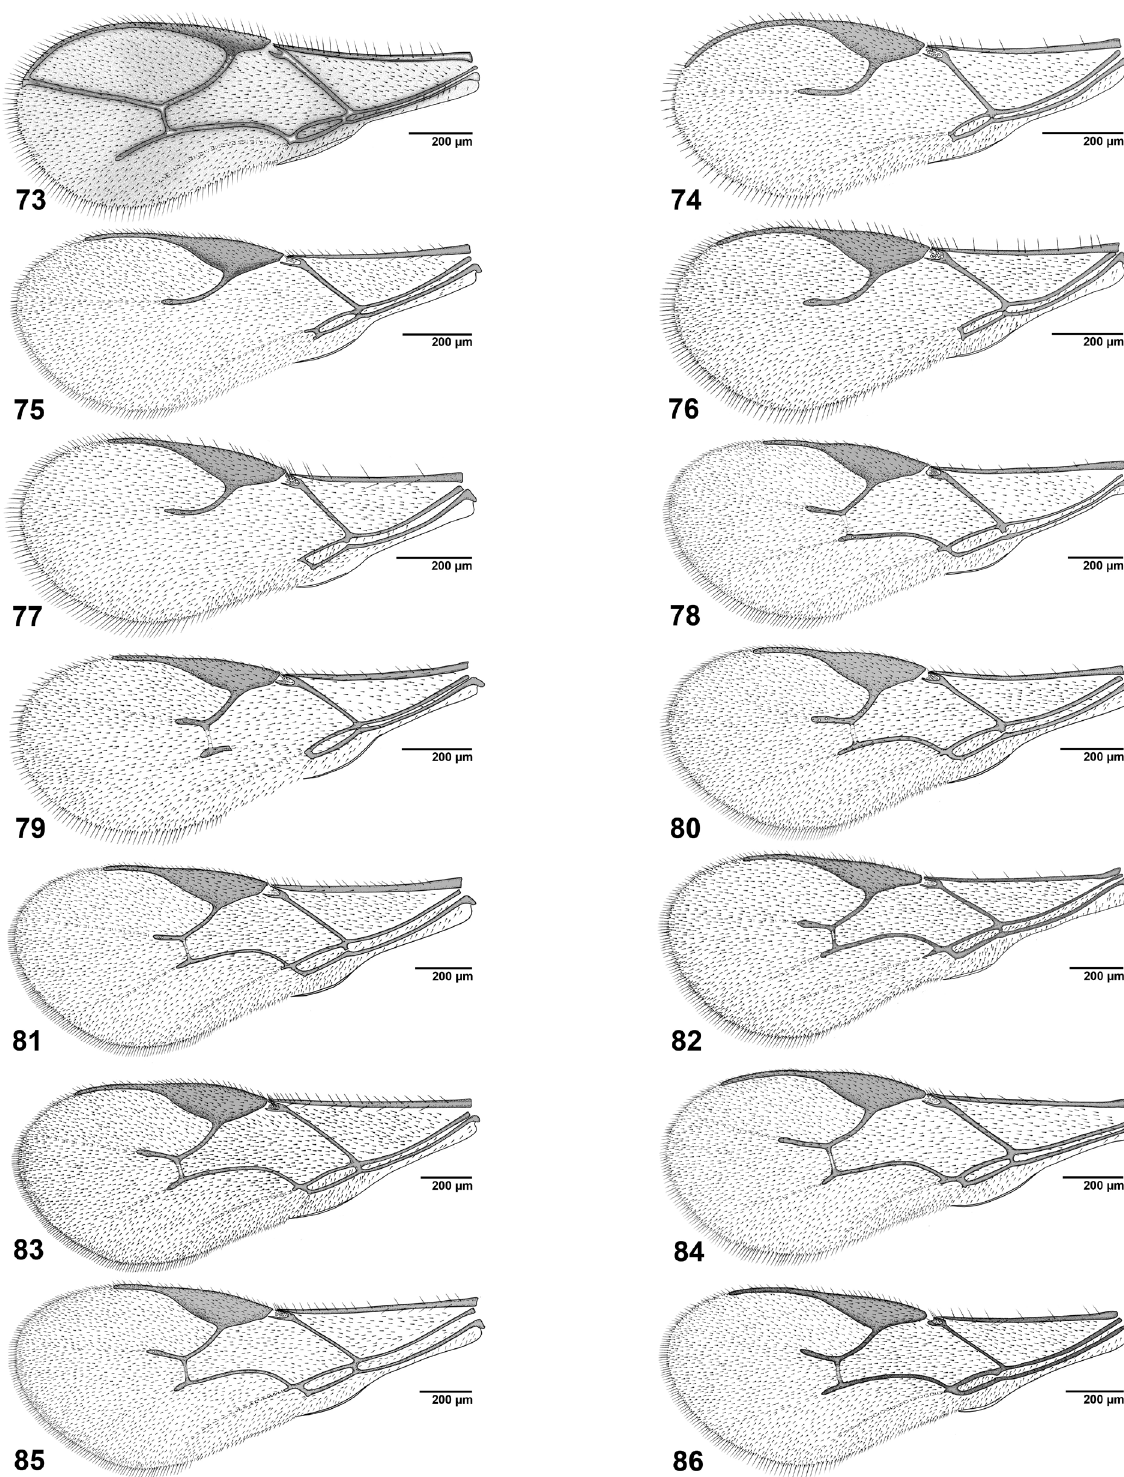
Figs 73–86. Forewing (♀): 73 . Aclitus obscuripennis . 74 . Adialytus ambiguus . 75 . Adialytus salicaphis . 76 . Adialytus thelaxis . 77 . Adialytus veronicaecola . 78 . Aphidius absinthii . 79 . Aphidius arvensis . 80 . Aphidius asteris . 81 . Aphidius avenae . 82 . Aphidius banksae . 83 . Aphidius cingulatus . 84 . Aphidius colemani . 85 . Aphidius eadyi . 86 . Aphidius eglanteriae